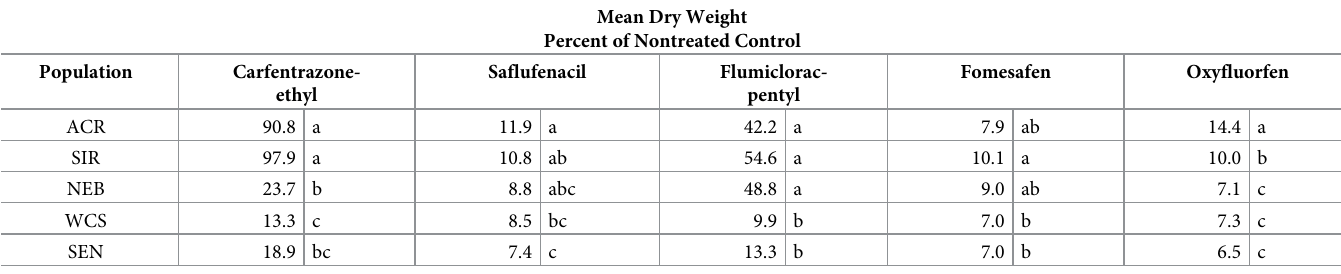
Table 2. Mean waterhemp biomass after treatment with field-use rates of PPO-inhibiting herbicides in the greenhouse.